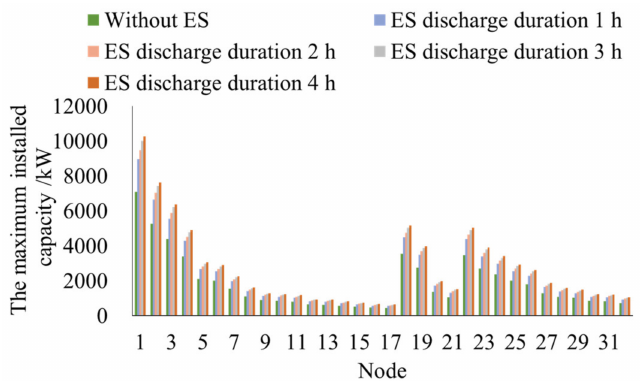
Figure 4. Maximum installed capacity of each node with and without